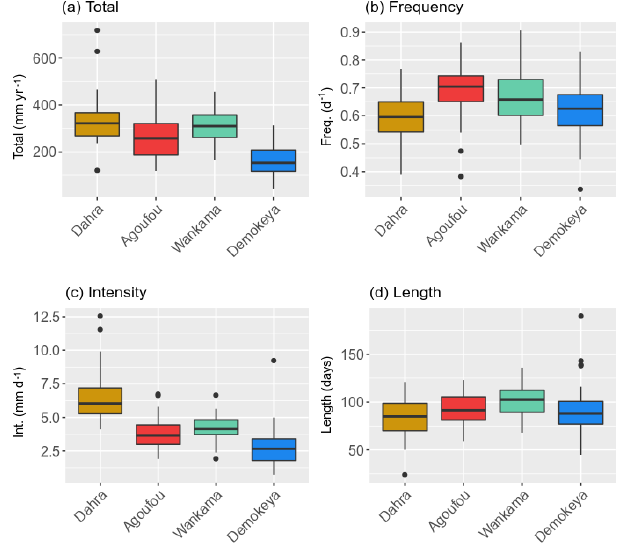
Figure 2. Median and variability of the rainy-season characteris- tics for the Sahel sites (Table 1) studied: (a) total annual rainfall, (b) event frequency, (c) event intensity and (d) rainy-season length (Table 3). Hinges represent the first and third quartiles; whiskers represent the largest (smallest) value at most 1.5 times the interquar- tile range above (below) the hinges; and dots represent outliers. Based on the daily MSWEP rainfall data for the period 1979–2016.